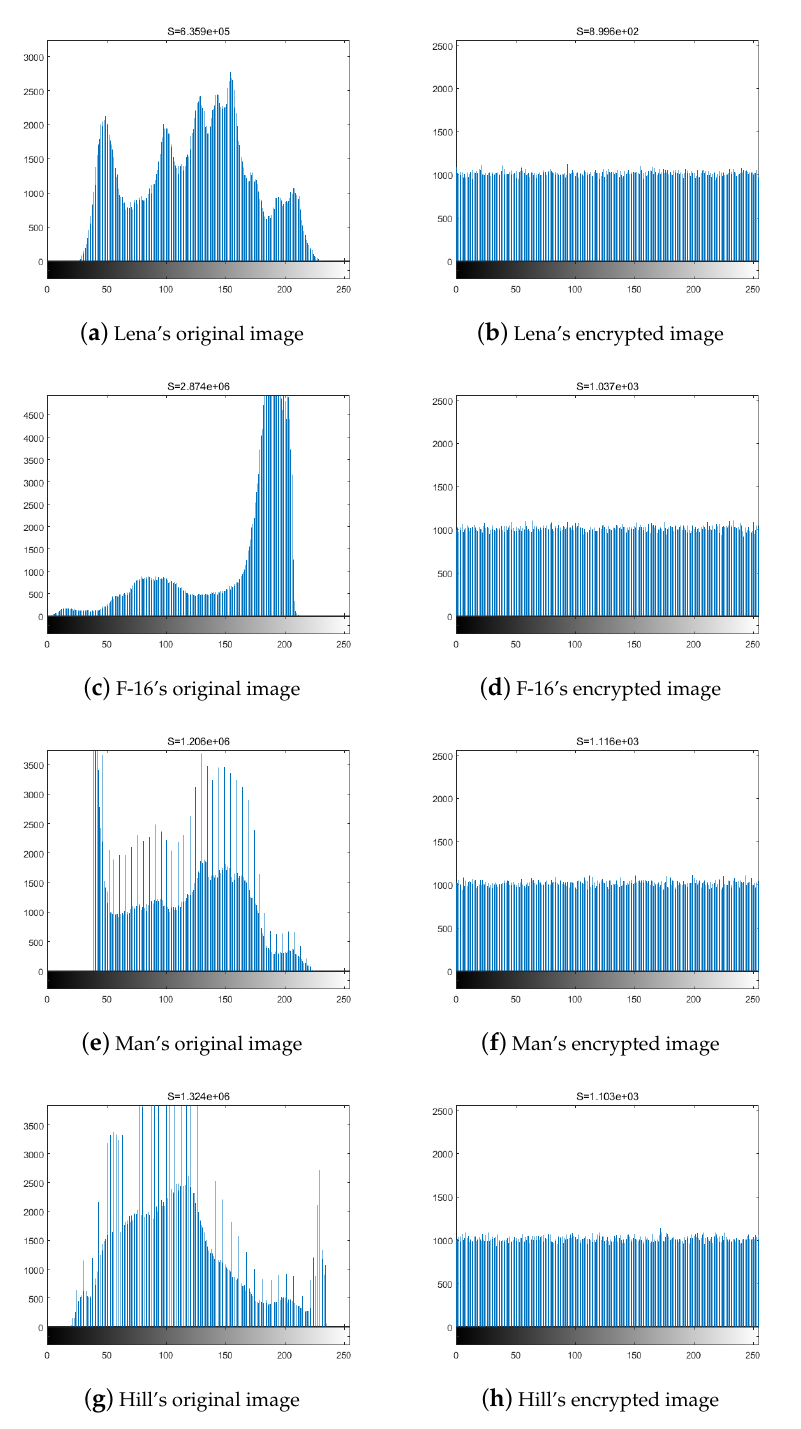
Figure 8. The histograms and variances of the images in Figure